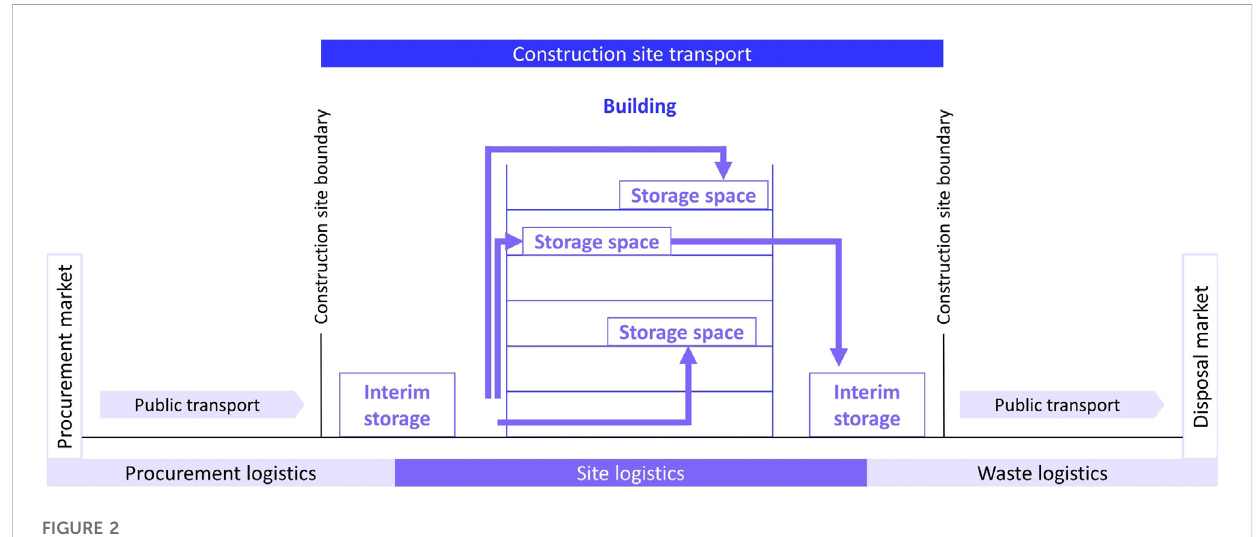
FIGURE 2 Logistics of a construction project/construction site transport (Blecken et al.,